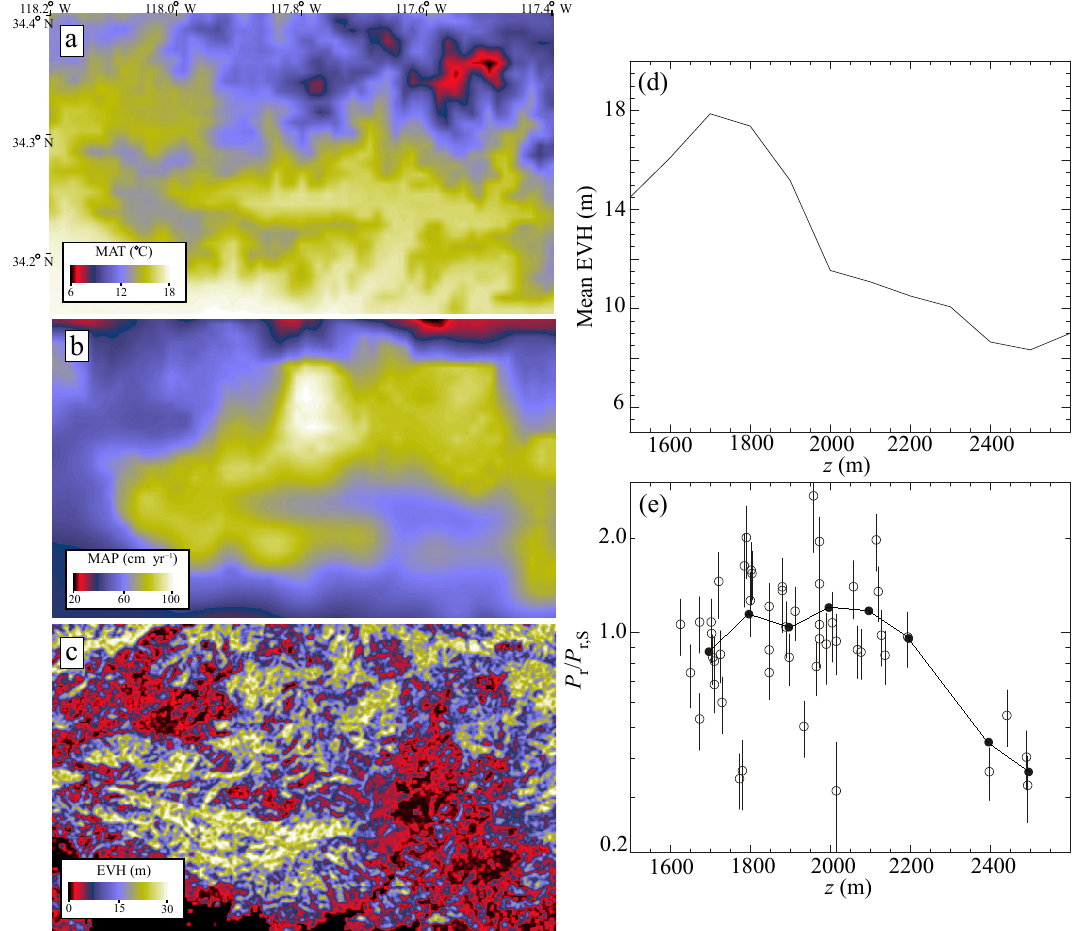
Figure 4. Climate and vegetation cover of the central San Gabriel Mountains. Color maps of (a) MAT and (b) MAP from the PRISM dataset (Daly et al., 2001). (c) Color map of mean EVH from the U.S. Geological Survey LANDFIRE database (U.S. Geological Survey, 2008). (d) Plot of mean EVH versus elevation above sea level, z , using the data illustrated in panel (c) . (e) Plot of the ratio of P r to P r ,S as a function of elevation. Filled circles are binned averages of the data (each bin equals 100m in